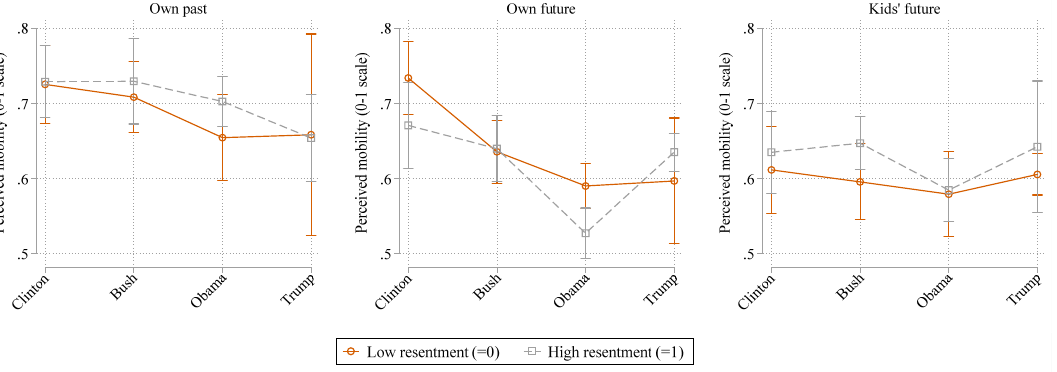
Figure 5. Perceived mobility among White respondents, by presidential administration and racial resentment. Confidence intervals are at the 95% level. Predictive margins are based on models in